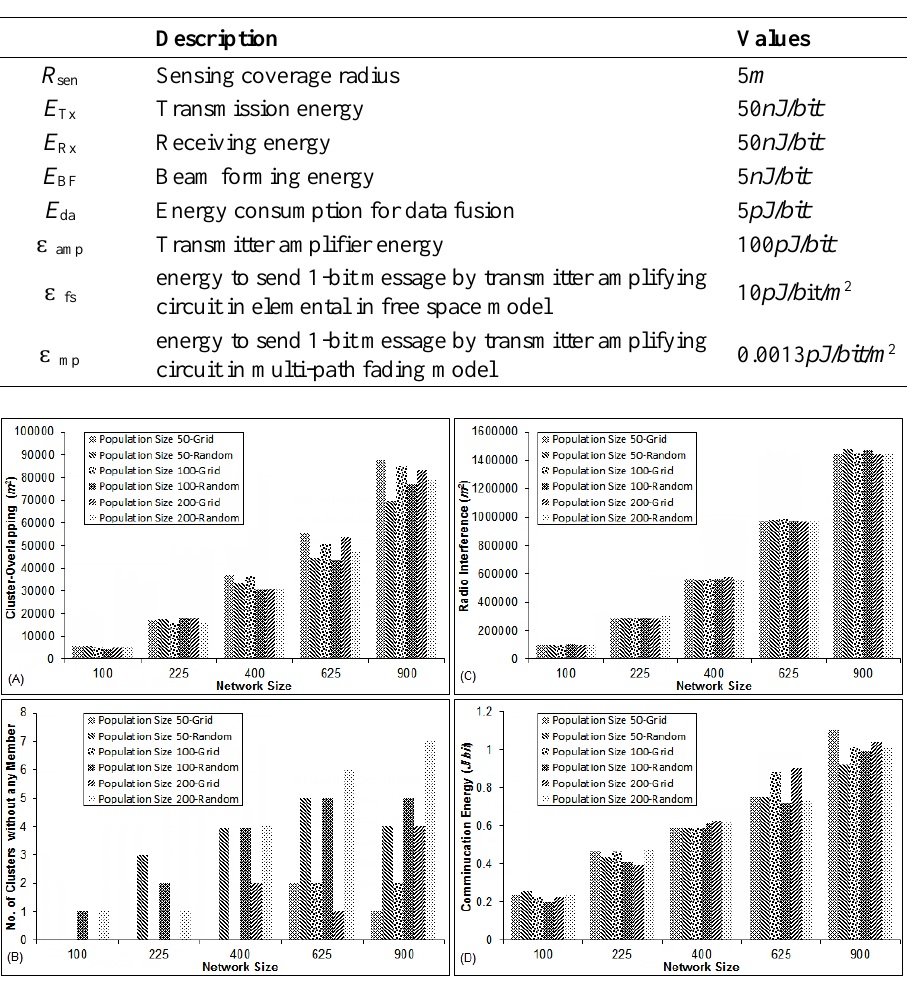
Table 5. Initial values for communication energy.